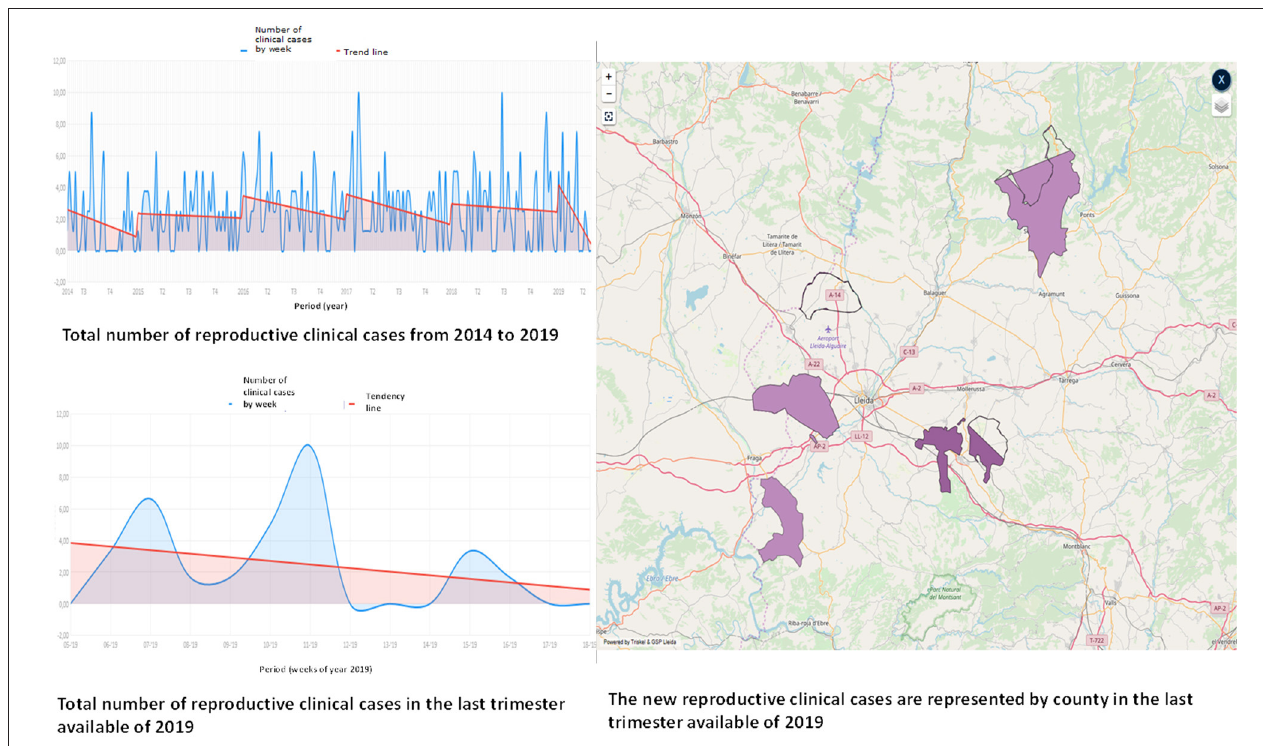
FIGURE 7 | Illustration of layout of the GSP web application to visualize the area and the trend of reported reproductive clinical